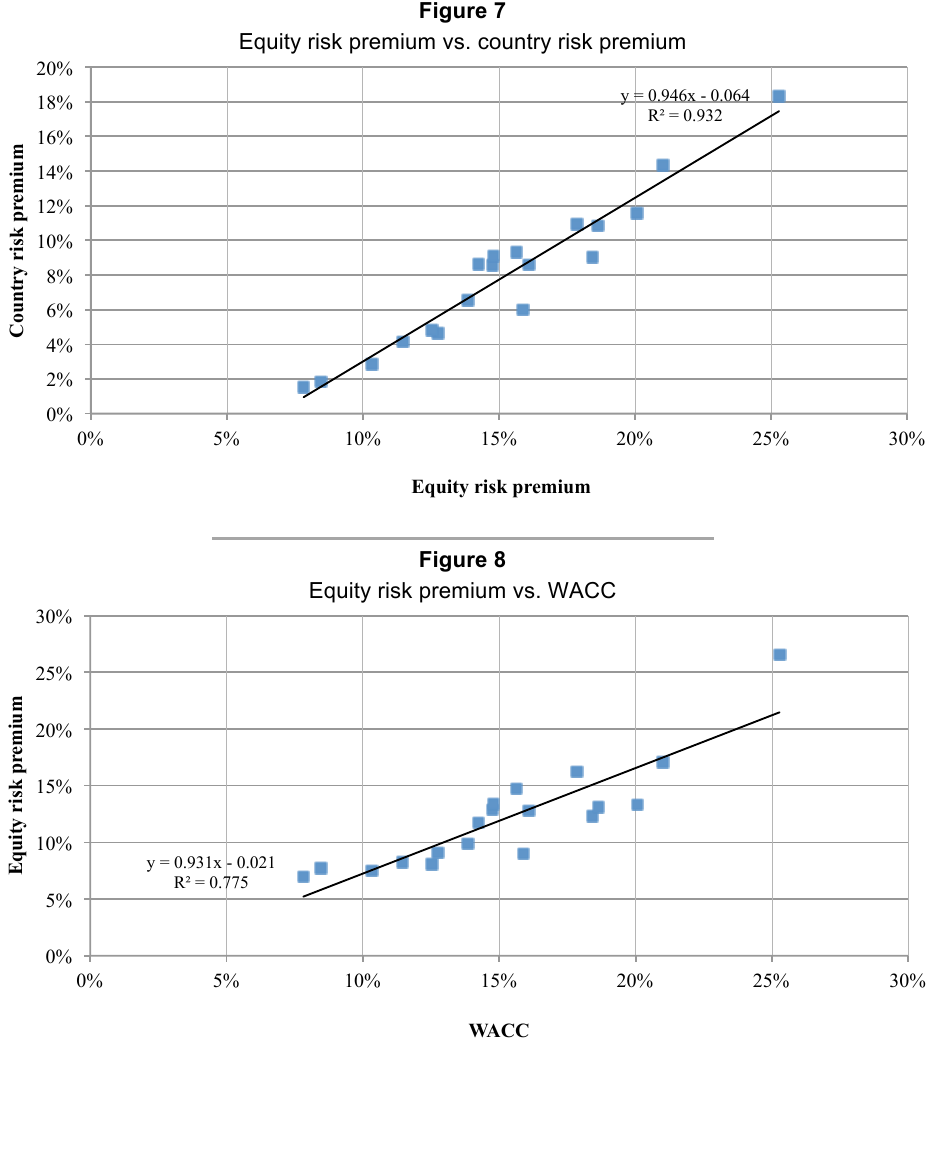
Equity risk premium vs.